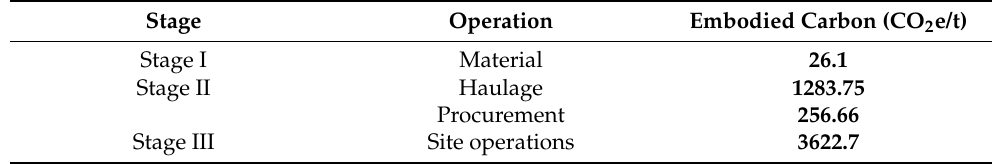
Table 7. Summations of stage wise carbon emissions with GS and CLS as a pavement application.